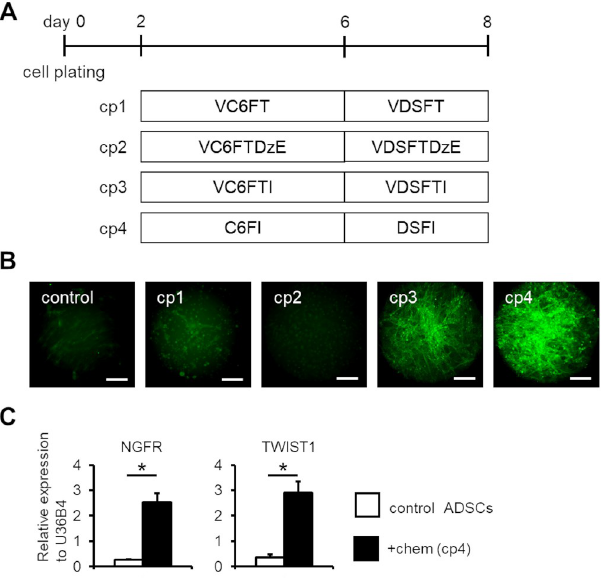
Fig 1. Neural crest cell induction of human ADSCs. (A) Schematic of the small molecular-based cell induction methods. Four combinations of small molecular cocktails (cp1-4) were tested. (B) Immunofluorescent analysis of NGFR expression in control and chemical-treated human ADSCs. Immunofluorescent analysis was performed on day 8 samples. Scale bar; 100 μ m. (C) qPCR analysis of neural crest marker genes NGFR and TWIST1 in control and chemical (the cp4 condition)-treated human ADSCs on day 8. The expression values were normalized to that of U36B4. ( n = 3, error bar shows SDs; two-sided Welch’s unpaired t -test for NGFR and two-sided Student’s unpaired t - test for TWIST1.). V; VPA, C; CHIR, 6; E-616452, F; FSK, T; Tranyl, D; DM, S; SB, Dz; DZNep, E; EPZ, and I; ISX9. � P <